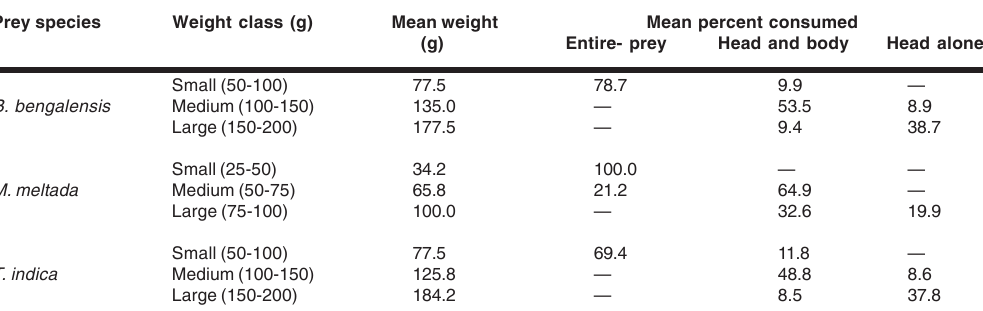
Table 4. Variations in the percent use of different body parts of the three prey species (when offered with three weight classes) by the Barn Owl T. alba (prey species were offered as single choice)